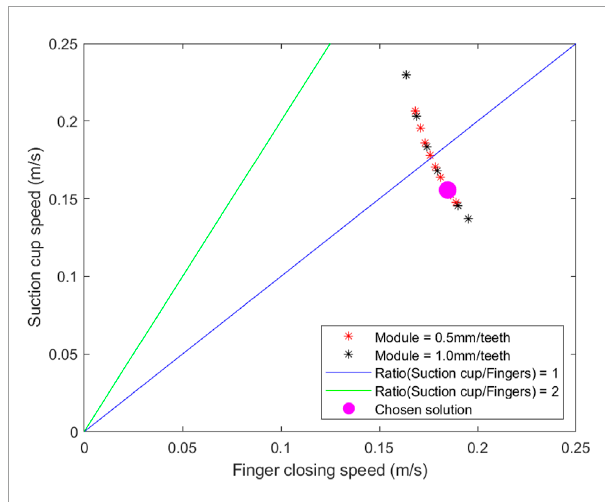
FIGURE 7 The finger and suction cup speeds of all the possible transmission